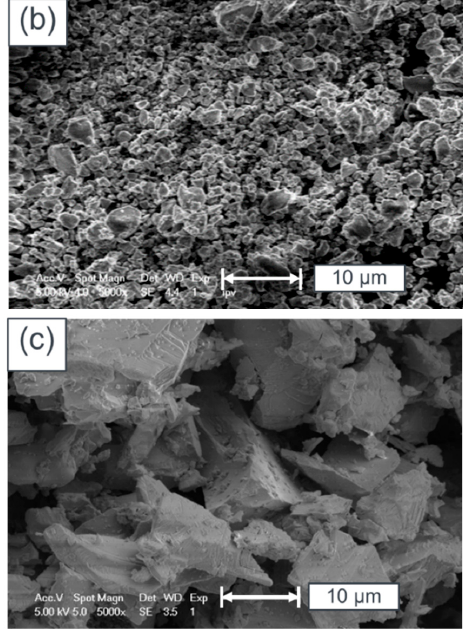
Figure 2. Secondary electron images from milled, unleached CdTe module pieces ( a ) same resolution as in Figure 1. ( b ) higher resolution. ( c ) Higher resolution micrograph from unleached CdTe 250 powder for comparison. Compared to the sieved CdTe powders, the milled module pieces have a much smaller mean particle size.